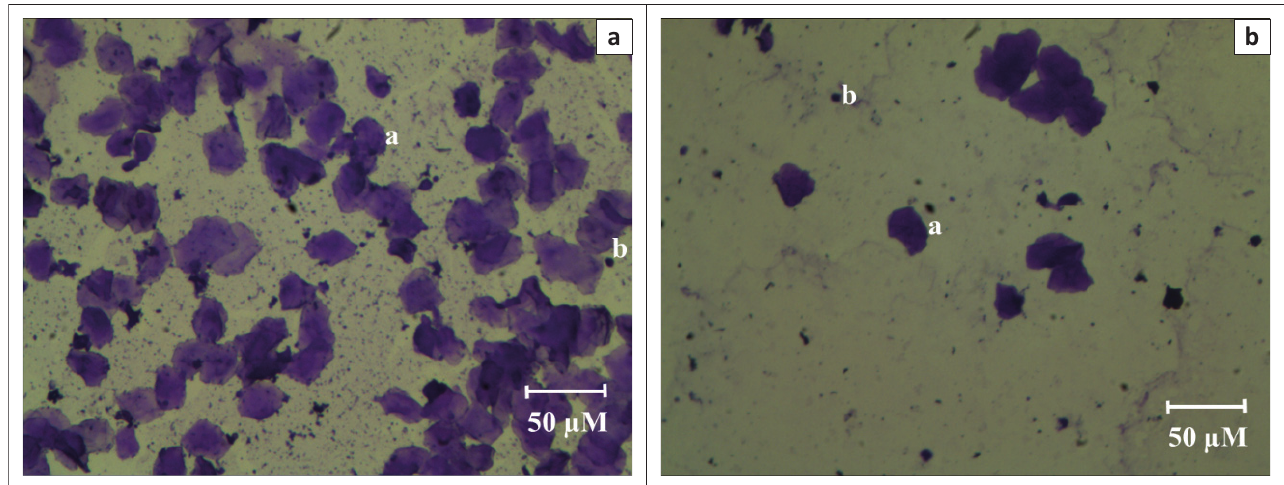
FIGURE 1: Representative ×100 images of gentian violet-stained exfoliative vaginal cytology from animals used in this study corresponding to: (a) oestrus with mainly anucleated cornified epithelial cells (a), (b) late pro-oestrus with nucleated cells undergoing cornification (a) and few lymphocytes